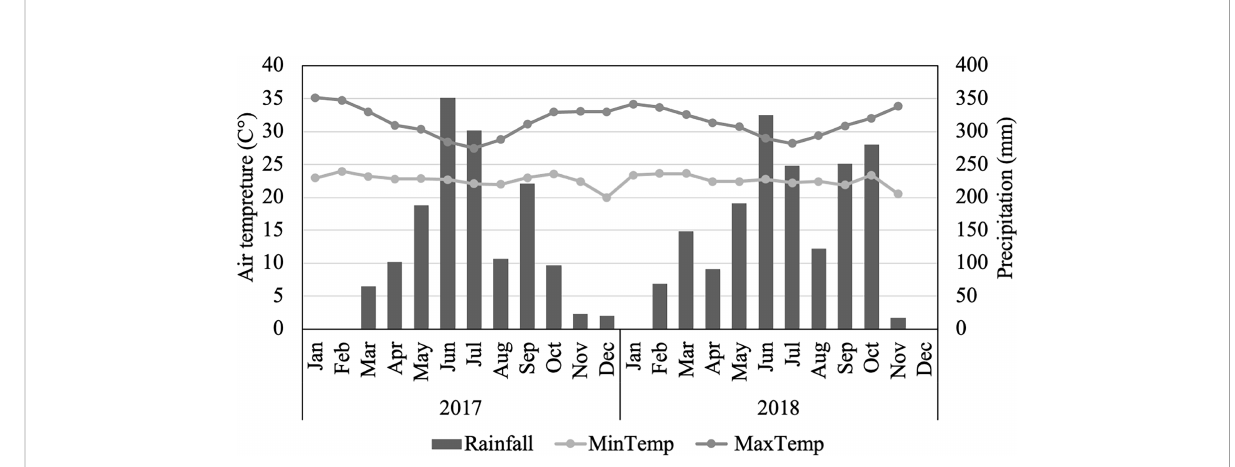
FIGURE 1 Air temperature and precipitation during the growth periods at the International Institute of Tropical Agriculture (IITA) Ibadan, Nigeria, in 2017 and 2018. Air temperature includes a black line and grey line representing maximum and minimum air temperature averages, respectively. For precipitation, data are cumulative values for every